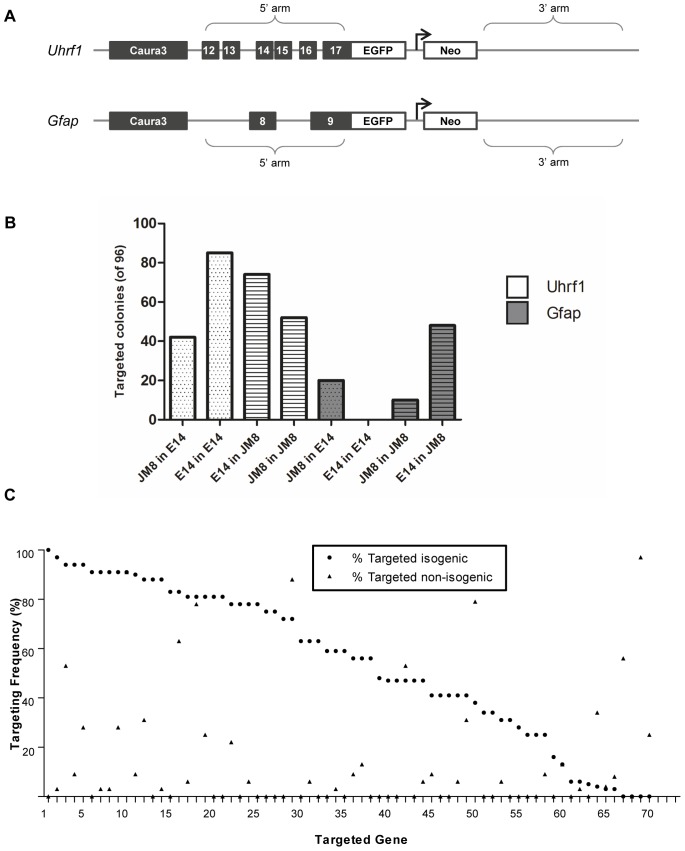
Targeting with isogenic and non-isogenic yeast-derived vectors.(A). Yeast-derived targeting vectors for Uhrf1 and Gfap genes are shown. Each vector contains homologous flanking genomic DNA derived directly from ES cell lines and a T2A-EGFP-promoter-Neo cassette cloned in-frame at the penultimate codon with the exon number shown. (B). To directly test if yeast-derived isogenic targeting vectors correlate with an increase in targeting frequency, targeting vectors for Gfap and Uhrf1 were electroporated into ES cells. For each gene, matched vectors and cell line (JM8 in JM8; E14 in E14) or reciprocal unmatched (JM8 in E14; E14 in JM8) electroporations were performed individually in parallel and triplicate. 32 colonies were picked from each plate and genotyped by long-range PCR, the number of correctly targeted colonies is shown. Whereas for Uhrf1, E14-derived DNA functioned better than JM8 in isogenic (E14 in E14) as well as unmatched (E14 in JM8) cells, isogenic targeting vectors for Gfap containing E14 DNA gave no correct colonies (E14 in E14) but performed well in unmatched cells (E14 in JM8). In all cases, E14 DNA performed best except Gfap targeting E14 in E14. (C). To further examine if isogenic DNA may be less efficient than unmatched DNA in certain cases, an independent targeting campaign of 70 genes was carried out in E14 and JM8 ES cells with tagging EGFP-promoter-neomycin vectors containing C57BL/6 targeting arms. The isogenic targeting frequency in JM8 (% of correctly targeted clones; •) was compared to non-isogenic targeting frequency in E14 cells (▴). A two-tailed paired t-test showed a strong preference for targeting with the isogenic construct (p<0.0001), while nine genes showed a preference for unmatched DNA. Gene order is as follows: 1, Lin28; 2, Stag3; 3, Dmap1; 4, Smc4; 5, Thoc4; 6, Auts2; 7, Cnot1; 8, Smc1b; 9, Smc1a; 10, Ube1x; 11, Ssrp1; 12, Ptbp1; 13, Smad2; 14, Thoc2; 15, March7; 16, Ruvbl1; 17, Cdc73; 18, Rad21; 19, Sorbs1; 20, Trim28; 21, Trrap; 22, Apc; 23, Rtf1; 24, Thoc3; 25, Zfp42; 26, Stat3; 27, Wdr61; 28, Esrrb; 29, Niban; 30, Dppa4; 31, Enth; 32, Ep400; 33, Cbx3; 34, Ddx18; 35, Tcfcp2l1; 36, Hipk2; 37, Klf5; 38, Svil; 39, Sf1; 40, Cebpa; 41, Ddx47; 42, Erk2; 43, Smad3; 44, Sox3; 45, Ctr9; 46, Pten; 47, Tbx3; 48, Tcf7l1; 49, U2af65; 50, Mcm2; 51, Tcfap2c; 52, Yeats4; 53, Npas3; 54, Ruvbl2; 55, Shfdg1; 56, Klf4; 57, Ppp4c; 58, Snciap; 59, Snrpf; 60, Nrob1; 61, Olig2; 62, Wdr5; 63, Mbd3; 64, Atxn1; 65, Cnot2; 66, Htt; 67, T (Brachyury); 68, Dab2; 69, Meg3; 70, Tcl1.